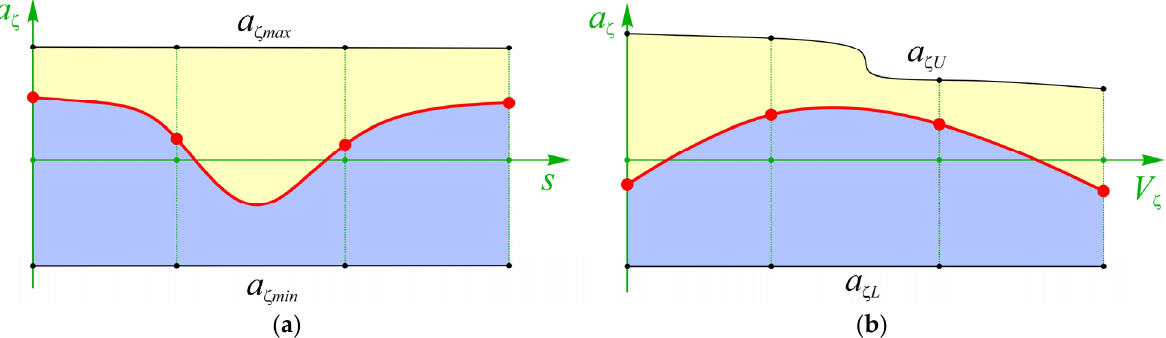
Figure 5. Integral approach to the longitudinal acceleration restriction: ( a )—provided by adhesion conditions, ( b )—provided by the propulsion system.